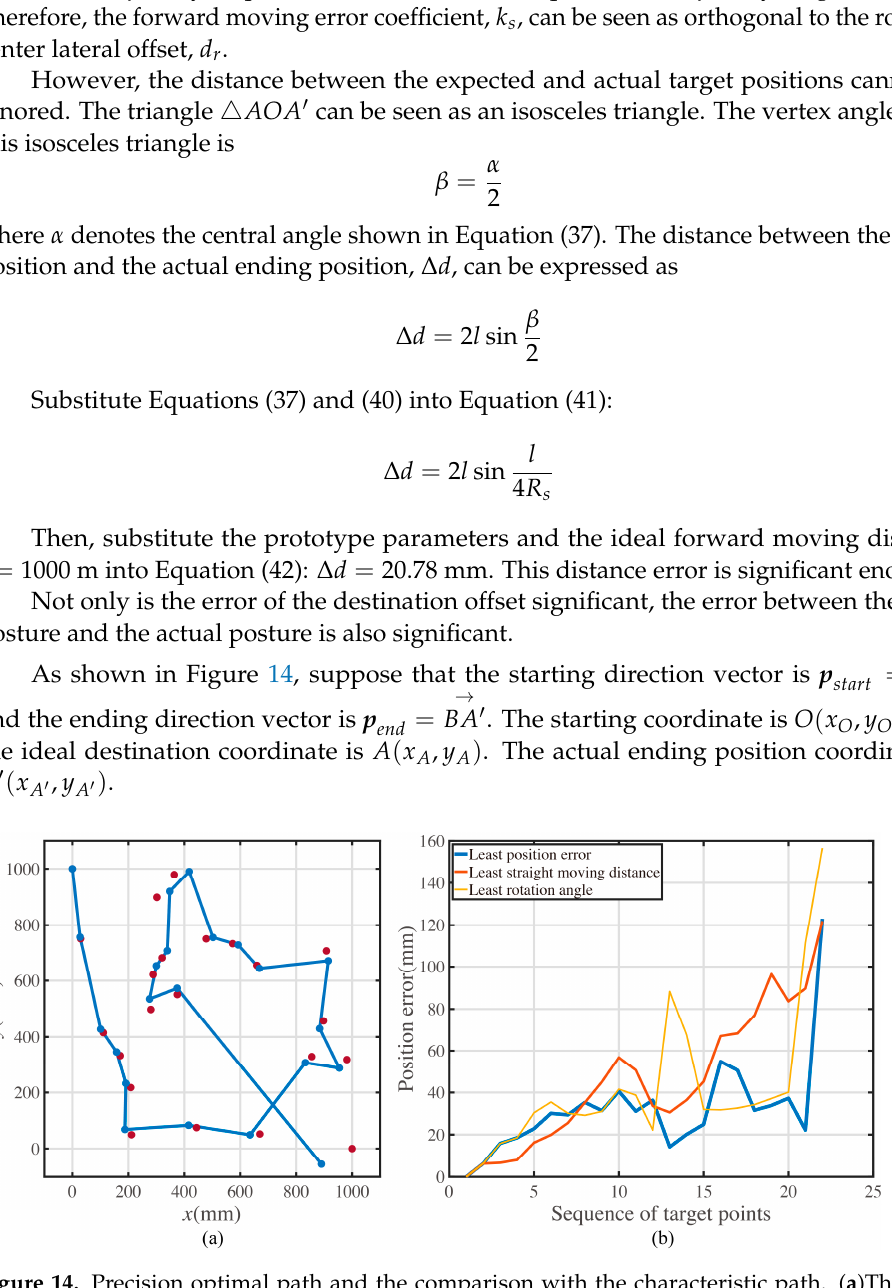
Figure 14. Precision optimal path and the comparison with the characteristic path. ( a )The ideal positions and the actual reached positions when the mobile robot moves along the precision-driven optimal path. ( b )The distances between the ideal positions and the actual reached positions at each target position when mobile robot moves along three different paths.